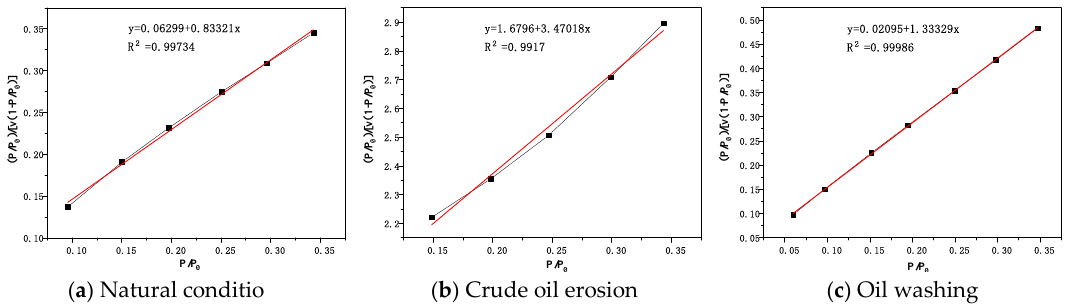
Figure 9. The BET diagrams of rock salt samples after different sample treatment conditions.